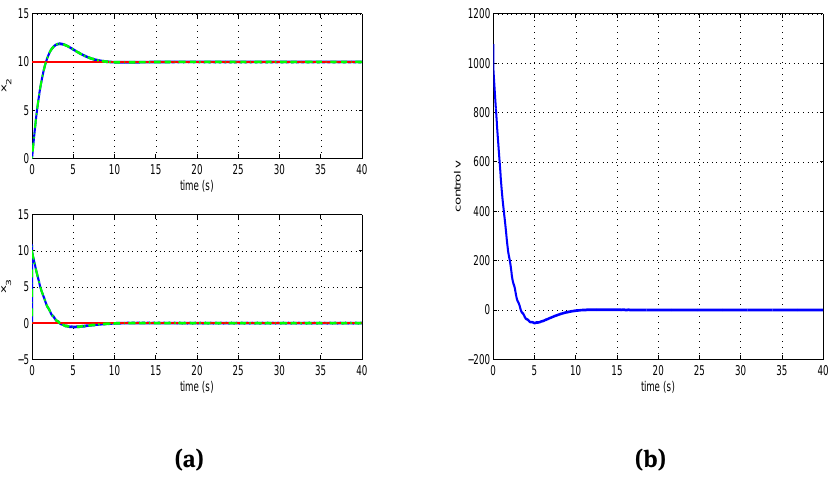
Fig. 3: Setpoint 1: (a) Convergence of the state variables of the SRM x 2 = ω , x 3 = ˙ ω (blue line: real value, green line: estimate value) by the H-infinity filter) to the associated reference values (red line). (b) Control input v applied to the control system of the SRM